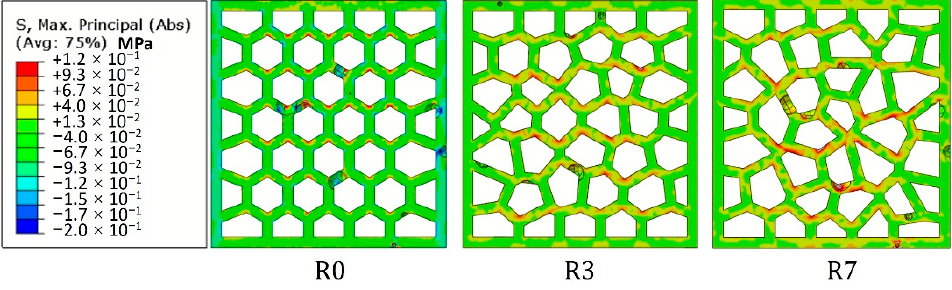
Figure 25. Stress distribution of the LCCCs within the elastic regime.